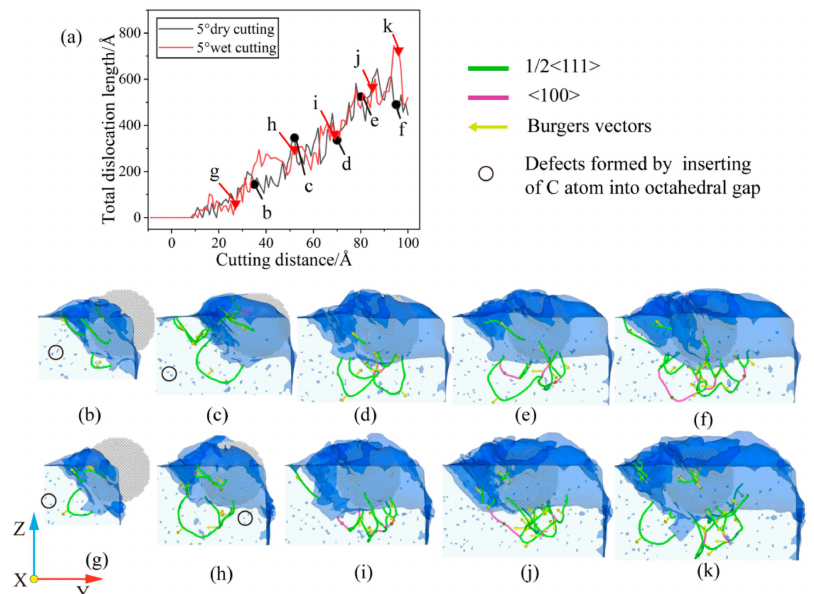
Figure 14. Dislocation evolution under θ = 5 ◦ . ( a ) Variation of total length of dislocation with cutting distance; ( b ) cutting distance of 35 Å under dry cutting; ( c ) cutting distance of 52 Å under dry cutting; ( d ) cutting distance of 70 Å under dry cutting; ( e ) cutting distance of 80 Å under dry cutting; ( f ) cutting distance of 94 Å under dry cutting; ( g ) cutting distance of 27 Å under wet cutting; ( h ) cutting distance of 52 Å under wet cutting; ( i ) cutting distance of 69 Å under wet cutting; ( j ) cutting distance of 85 Å under wet cutting; and ( k ) cutting distance of 96 Å under wet cutting.